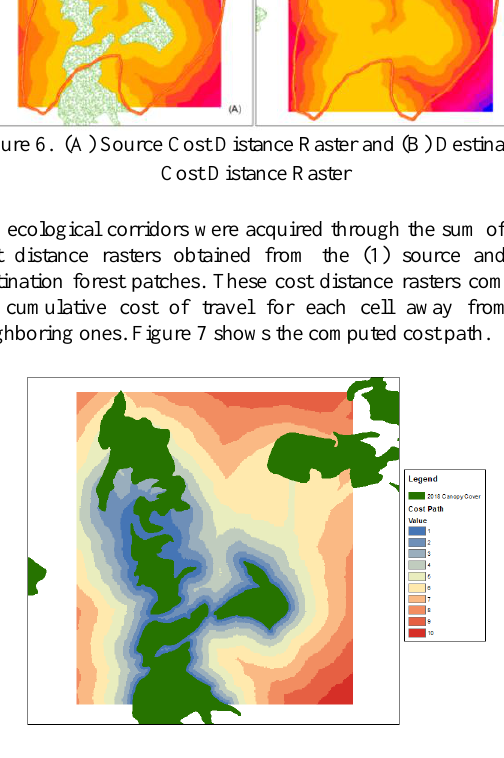
Figure 7. Cost path raster in linking different forest fragments